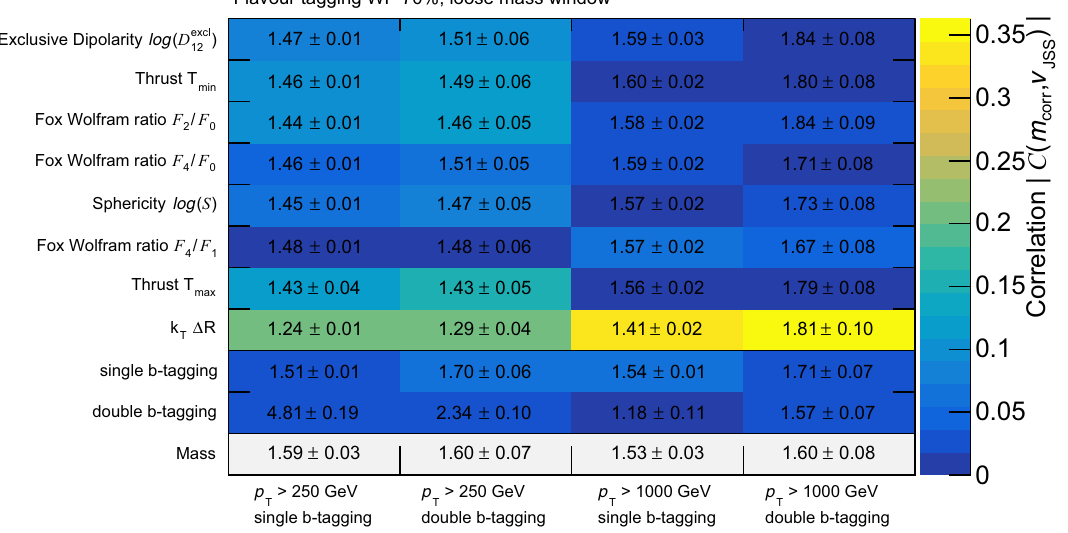
Fig. 12 Hadronic top-quark background rejection at 80% signal effi- ciency( ε S = 80%)foravarietyofsubstructurevariablesusingdifferent benchmarks in terms of b -tagging strategy and transverse momentum range.The z -axiscolourscalerepresentstheabsolutevalueofthelinear-